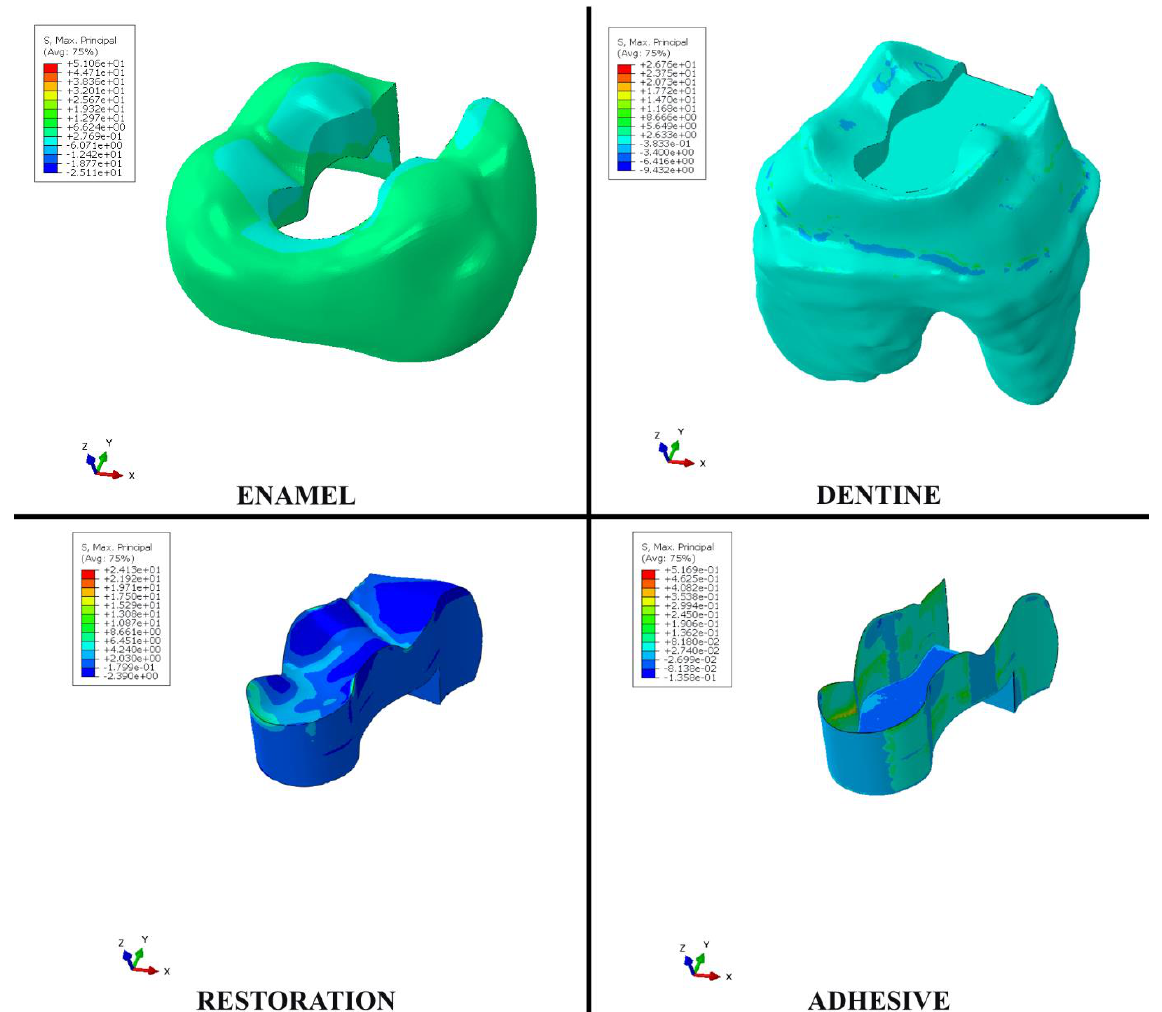
Figure 7. Distribution of stress areas in enamel, dentin, restoration, and adhesive material when composite resin is used as a restorative material.